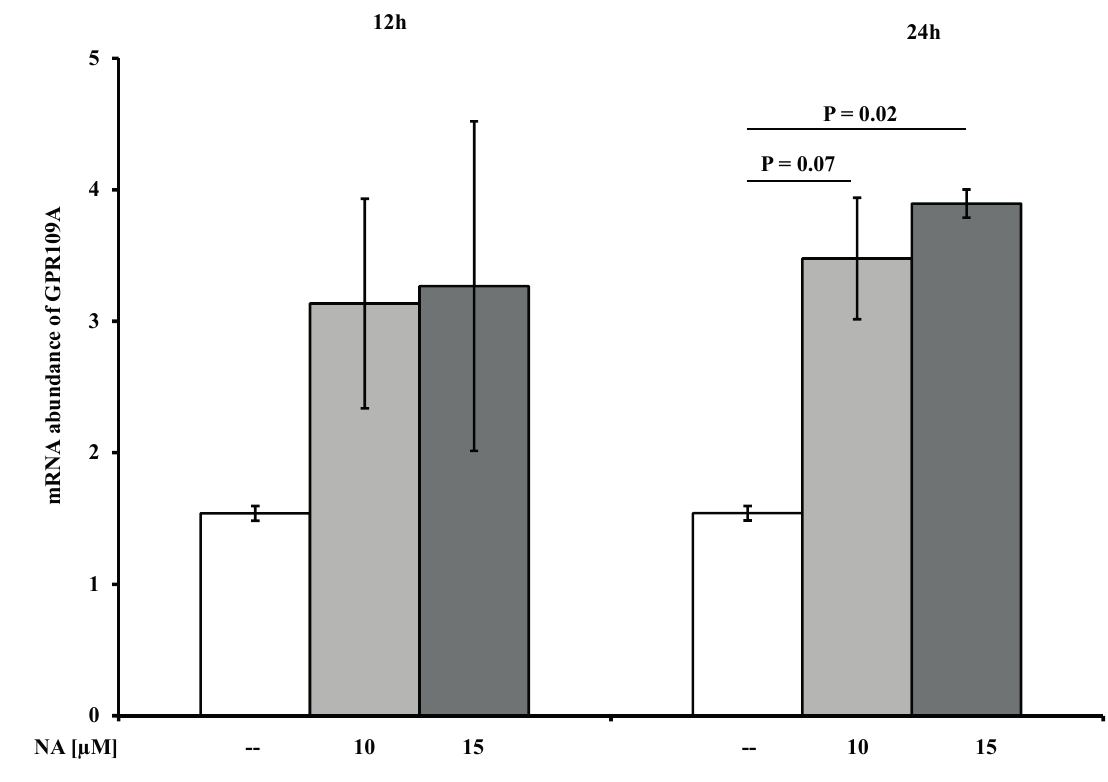
Figure 3. The effects of nicotinic acid (NA) on the mRNA abundance of G-protein coupled receptor 109A (GPR109A) in differentiated bovine adipocytes cells ( n = 10). After 4 h of starvation, the adipocytes were pre-incubated with (PTX (+)) or without pertussis toxin (PTX ( − )) (100 ng/mL) for 16 h and then treated for 12 or 24 h with 10 or 15 µM NA or PBS (control). Due to the absence of differences, the PTX (+) and PTX ( − ) groups were merged for the analyses of the mRNA abundances. Significant differences ( p ≤ 0.05) and trends ( p ≤ 0.1) are designated with the corresponding p -values.